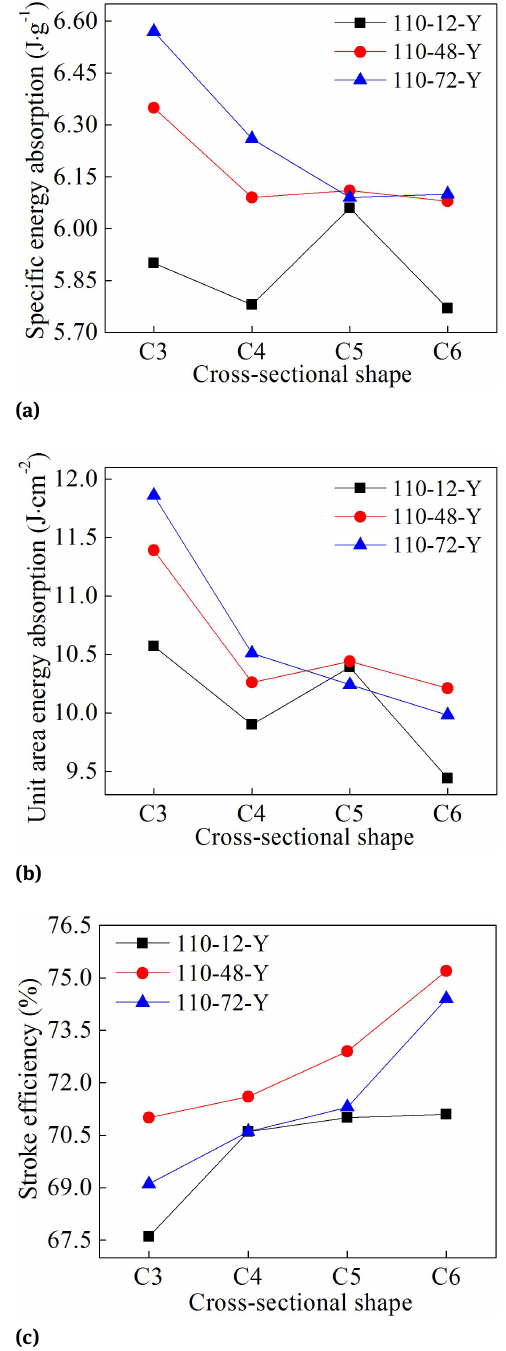
Figure 12: Effects of different cross-sectional shapes of paper cor- rugation tube along Y direction on cushioning energy absorption parameters: (a) specific energy absorption; (b) unit area energy absorption; (c) stroke eflciency